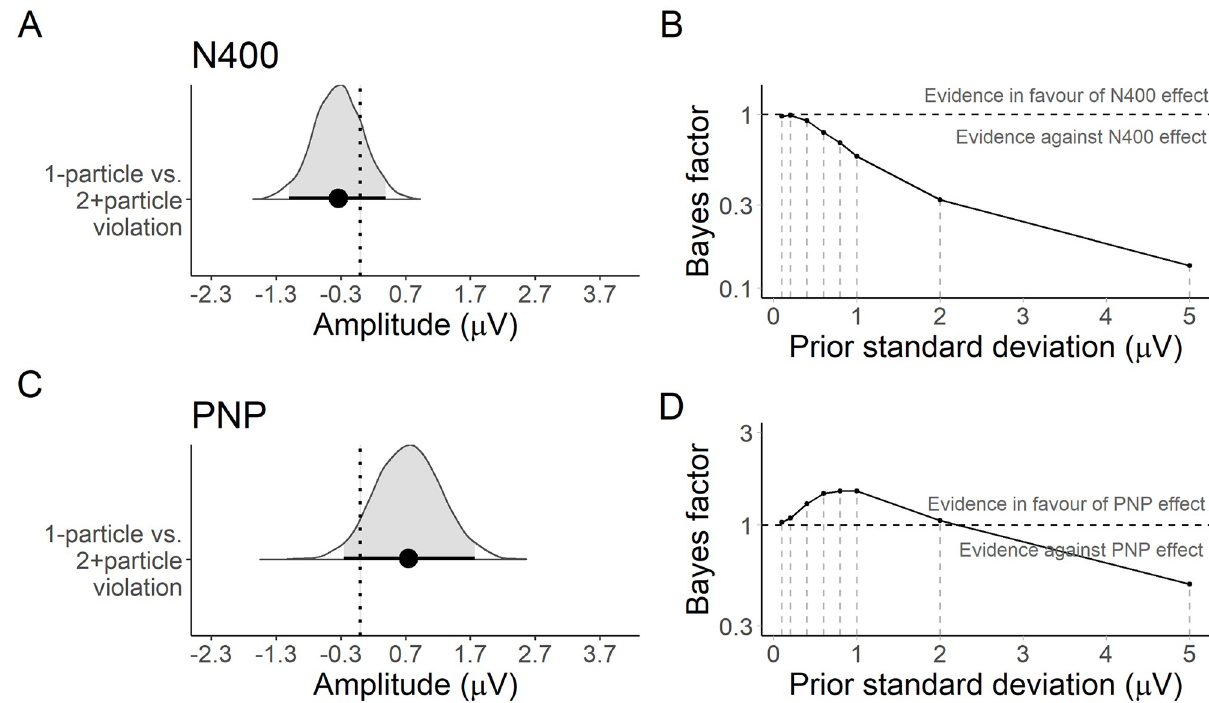
Fig 2. Experiment 1: Posterior estimates and Bayes factor analysis for the planned and exploratory comparisons. A . The posterior distribution represents the estimated change in N400 amplitude associated with violations in the 1-particle condition relative to the 2+particle condition. The point and errorbar reflect the posterior mean and 95% credible interval. B . Bayes factors computed under a range of priors comparing models with and without a predictor for the 1- vs. 2+particle condition manipulation. A Bayes factor of 1 indicates no evidence in favour of either model. Bayes factors below 1 indicate evidence against a difference in N400 amplitude associated with the manipulation. C . Posterior distribution of the difference in PNP amplitude between the violation conditions. D . Bayes factors under a range of priors for the PNP effect.